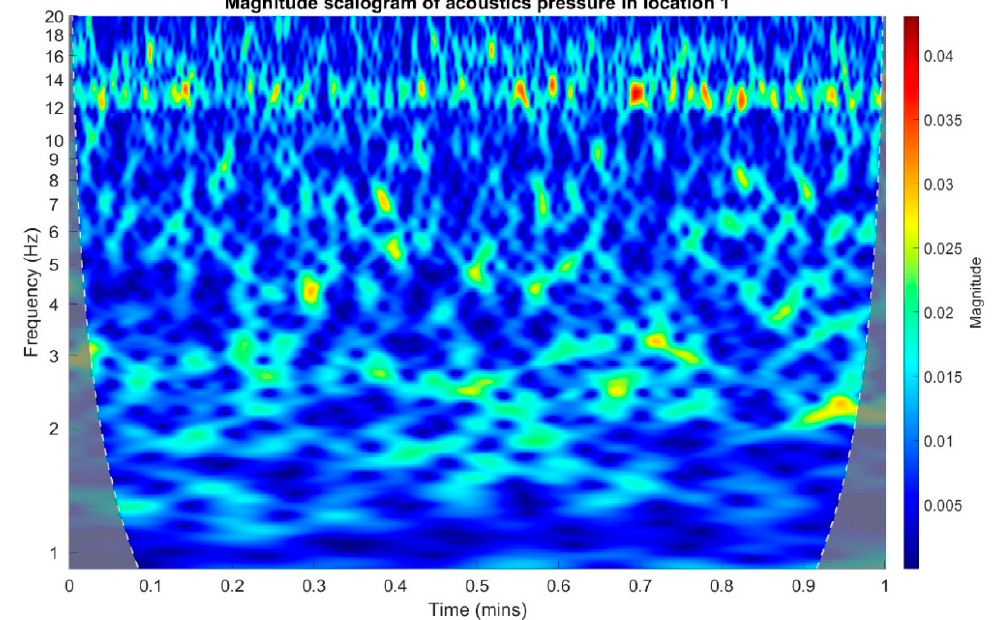
Figure 20. Magnitude scalogram of acoustic pressure in location 1.